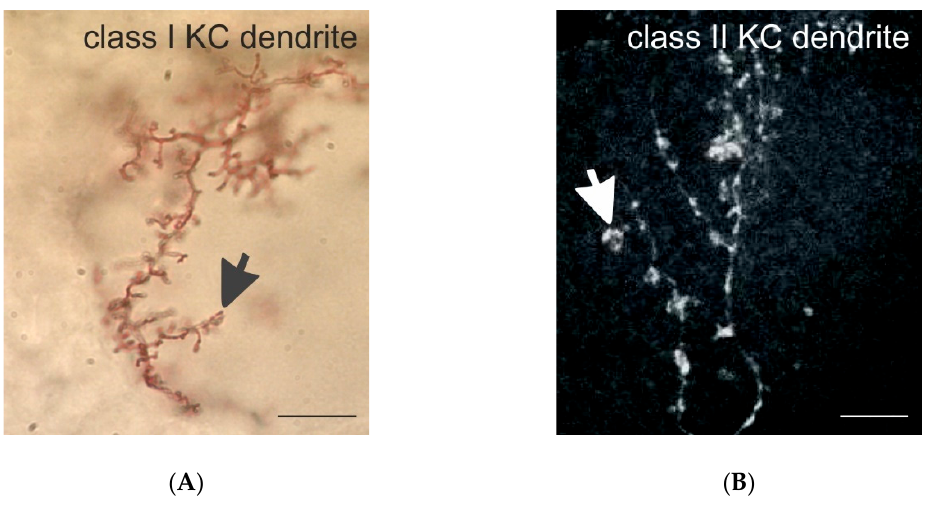
Figure 2. Class I and II KC dendrites in the honeybee. ( A ) Golgi-impregnated dendritic spines of a class I (spiny) KC in the MB-calyx lip. The black arrow marks a dendritic spine. ( B ) Dendritic branches of a class II (clawed) KC in the lip filled with Neurobiotin using iontophoretic injection techniques. The white arrow marks a single dendritic claw. Scale bars in ( A , B ) = 10 µ m. Images provided by Malu Obermayer in ( A ) and by Kathrin Gehring in ( B